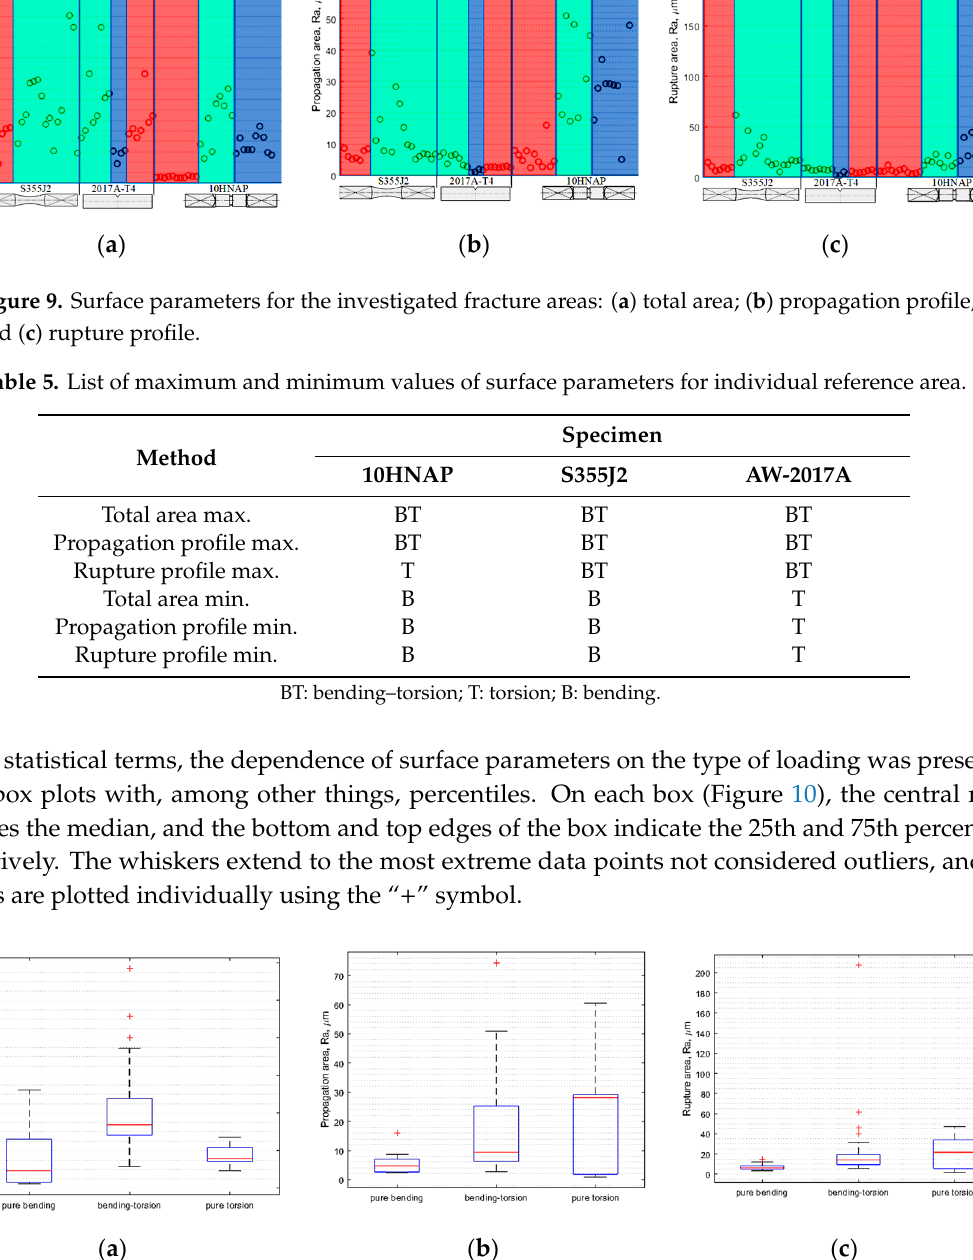
Table 6. Median extremum for individual reference areas. Reference Area/Median Extremum